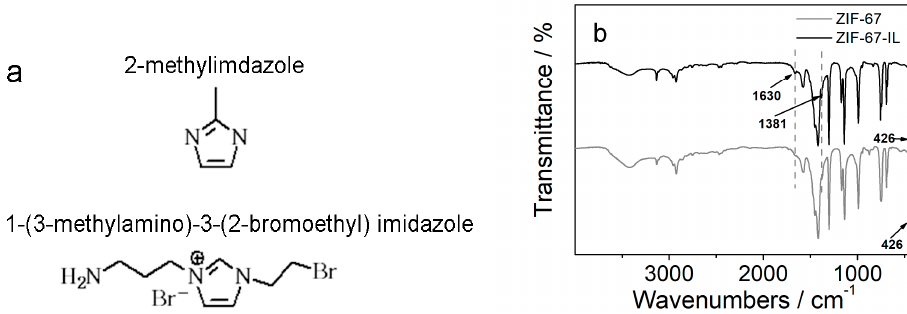
Figure 1. ( a ) The chemical structure of precursors used for formation of ionic-liquid-modified zeolitic imidazolate framework (ZIF-67-IL). ( b ) Fourier-transform infrared (FTIR) spectra of ZIF-67 (gray line) and ZIF-67-IL (black line). The dashed lines are guides for the eyes.